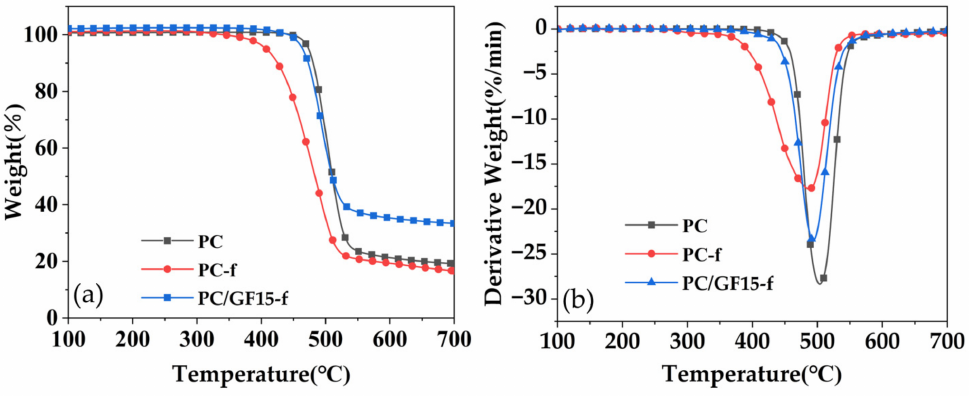
Figure 14. ( a ) TGA mass weight loss curves and ( b ) DTG curves for PC, PC-f and PC/GF15-f